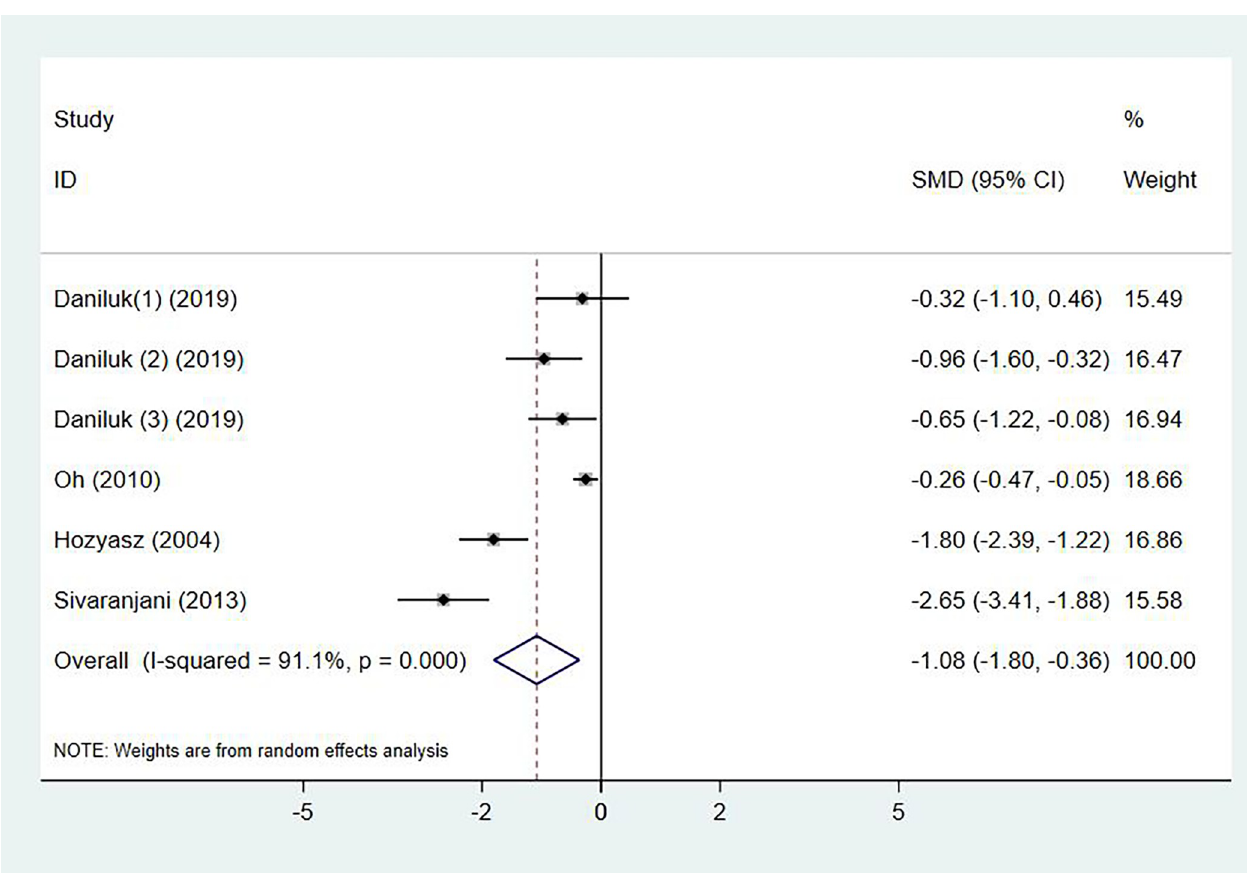
Fig 4. Forest plot in the meta-analysis of vitamin E levels and atopic